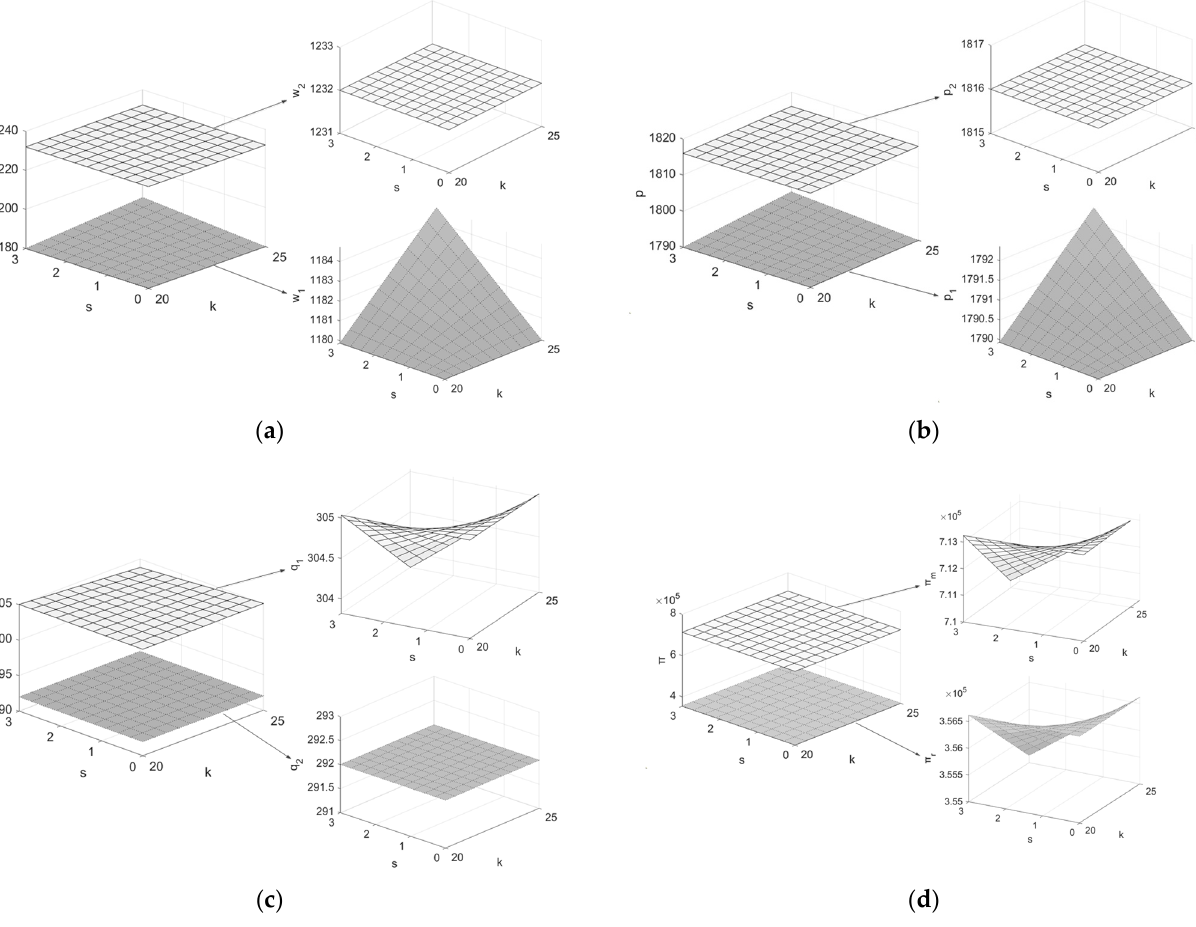
, w w s on 1 2 ; ( b ) effects of